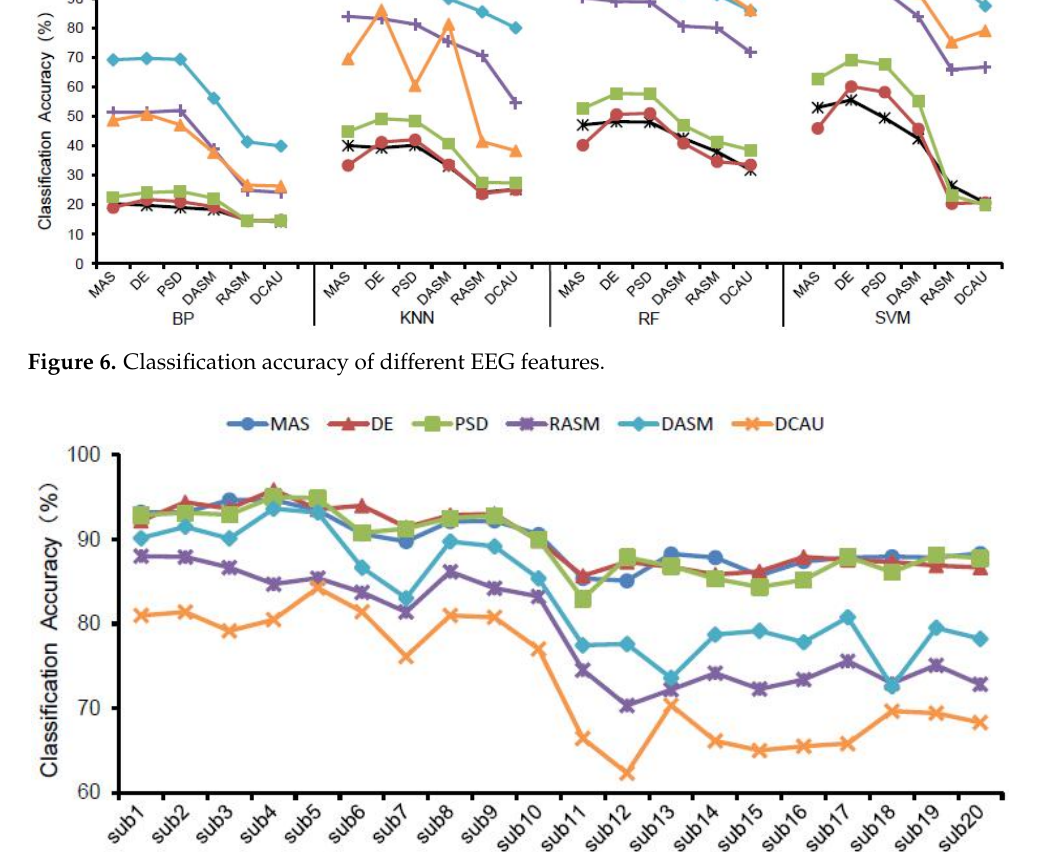
Figure 7. The highest classification accuracy of different EEG features in all bands in 20 subjects.